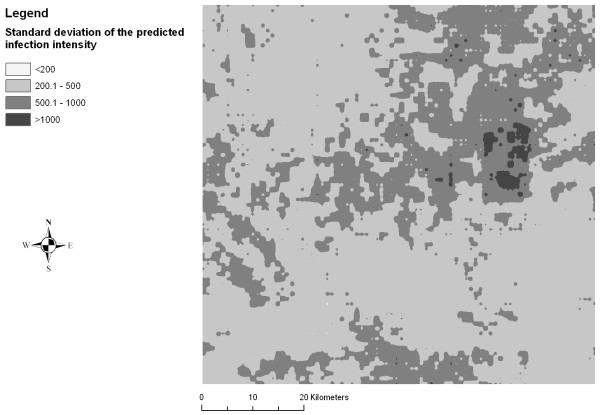
Standard deviation map of the predicted P. falciparum parasitaemia derived from a stationary negative binomial regression model using Bayesian kriging in the region of Man, western Côte d'Ivoire.